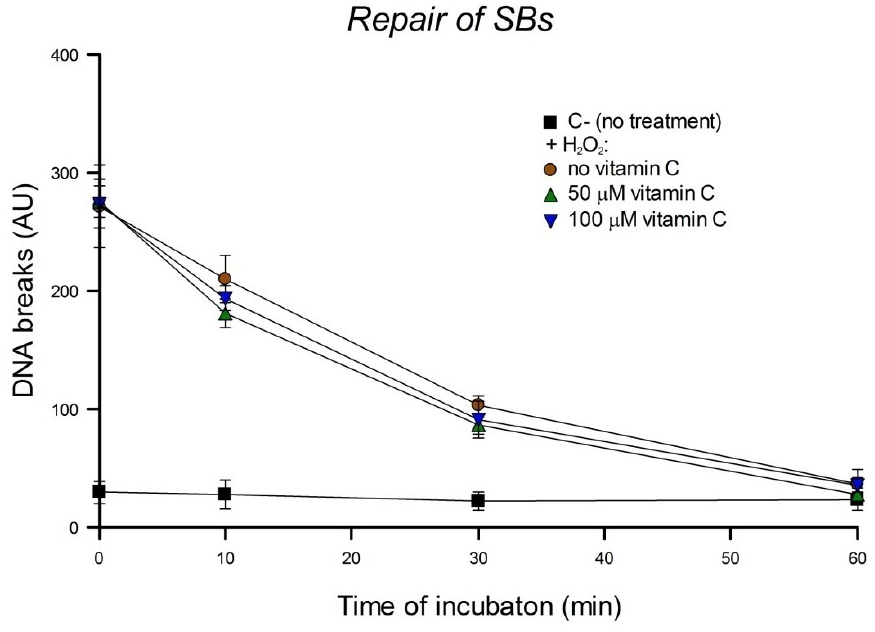
Figure 4. Effect of overnight pre-incubation of HeLa cells with different concentrations of vitamin C on the kinetics of repair of SBs: residual SBs were measured after different times of incubation after H O treatment. C-: control cells without any kind of treatment. 2 2 Bars: SD calculated from the results of 3 independent experiments. No significant effects were